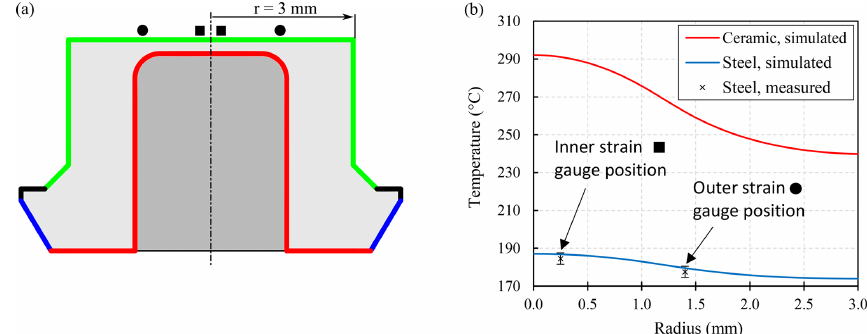
Figure 7. (a) Thermal boundary conditions of the membrane. Red: time-dependent heat flux from the combustion, green: thermal convection to air (air temp. 120 ◦ C), black: weld to sensor housing (150 ◦ C), blue: contact to cylinder head (180 ◦ C). (b) Simulated temperature profile over the membrane’s top side for steel and ceramic. In addition, the measured temperatures at the appropriate strain gauge positions are